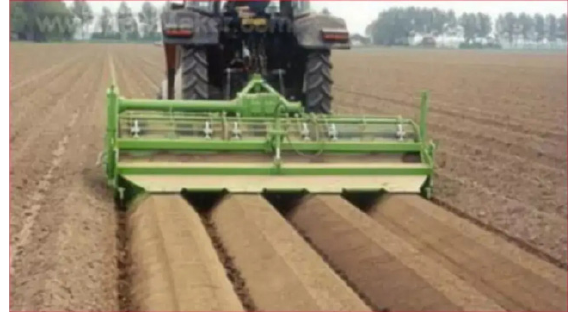
Figure 5. Potato ridging planting.